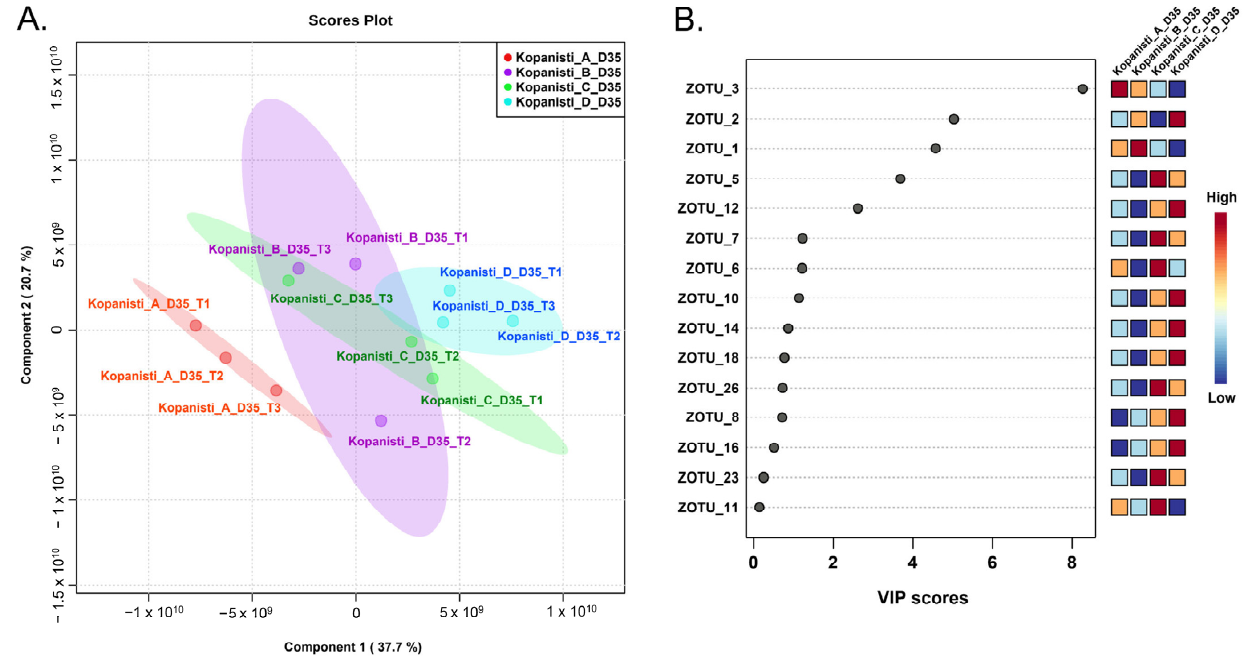
Figure 7. Partial least squares discriminant analysis (PLS-DA) of the yeasts/fungi zOTUs detected in the Kopanisti A, B, C and D samples on Day 35. Samples are coloured according to the Kopanisti type, i.e., red for Kopanisti A, purple for Kopanisti B, green for Kopanisti C and blue for Kopanisti D ( A ). Most influential yeasts/fungi zOTUs of the Kopanisti A, B, C and D samples on Day 35 based on the Variable Importance in Projection (VIP) scores from the PLS-DA. The colour bar indicates the intensity of the variable in the respective Kopanisti type ( B ).